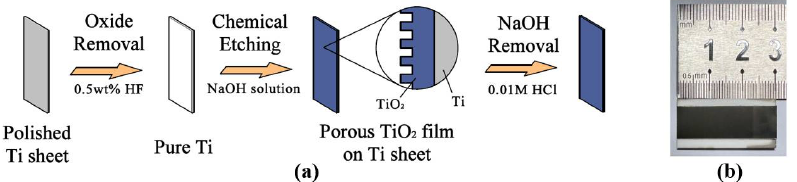
Figure 1. ( a ) Scheme of the sensitive electrode fabrication procedure and ( b ) photograph of the sensitive electrode.